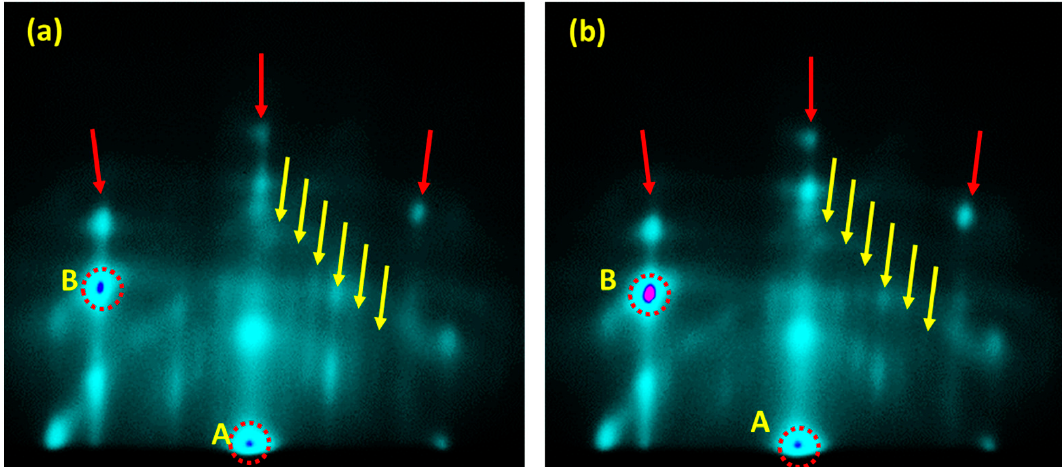
Figure 2. RHEED patterns ( a ) before the Al deposition and ( b ) after the completion of the Al layer. The red arrows indicate the 1 × 1 pattern of the c-S(111) wafer. The yellow arrows indicate the strikes of the 7 × 7 surface structure. The intensity of the A and B spots enhances as an Al(111)-1 × 1 layer is formed (as seen by comparing the B spot intensities in both figures).